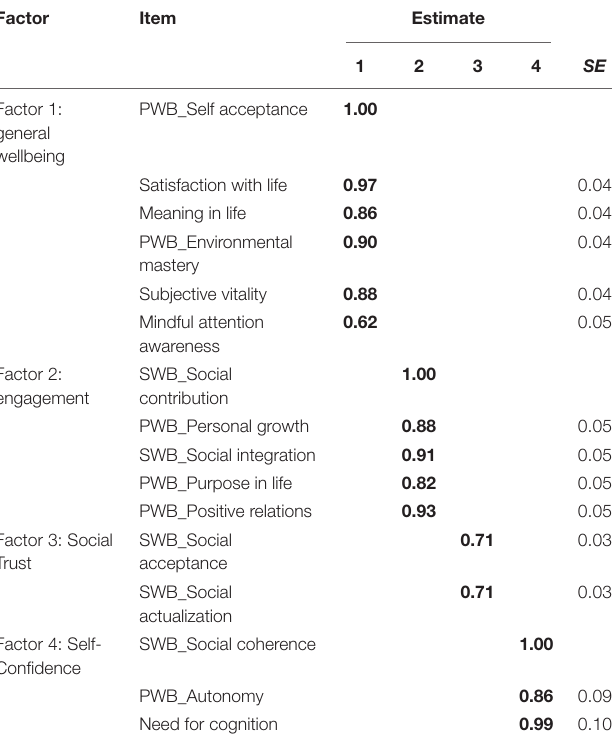
TABLE 5 | CFA loadings and standard errors